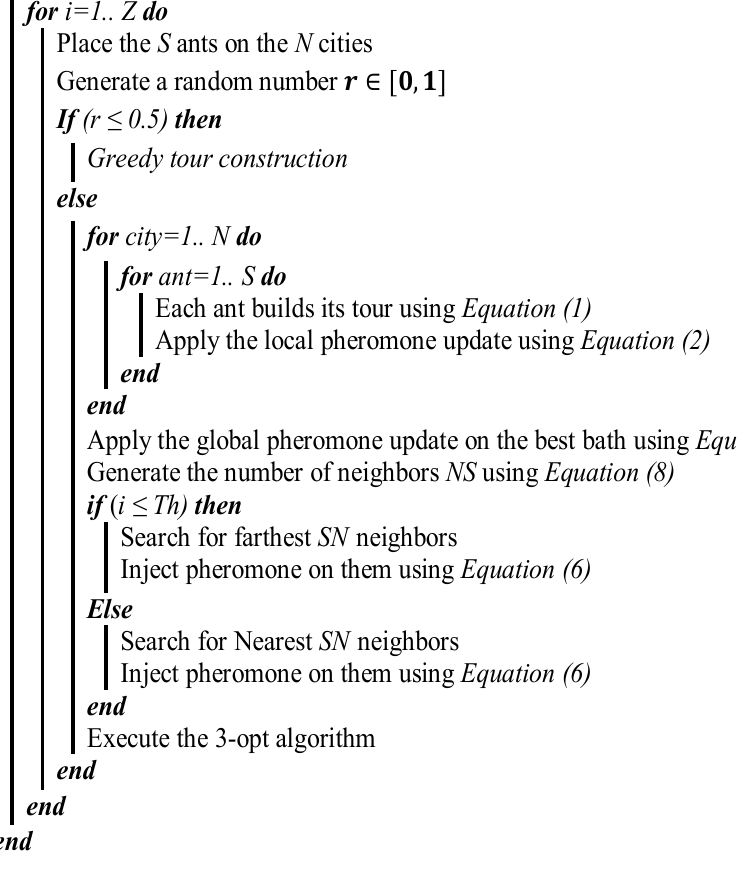
Figure 4. The dynamic FACO (DFACO) algorithm.